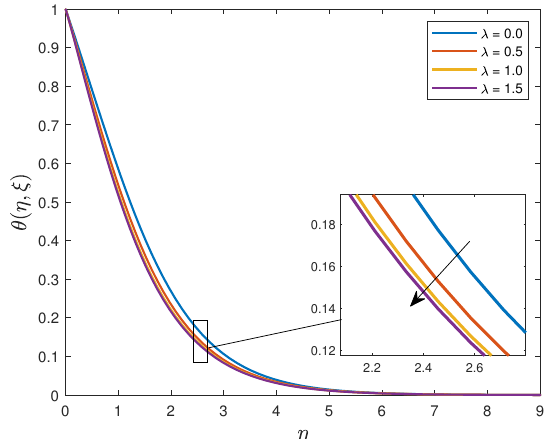
Figure 5. The influence of λ on fluid temperature.